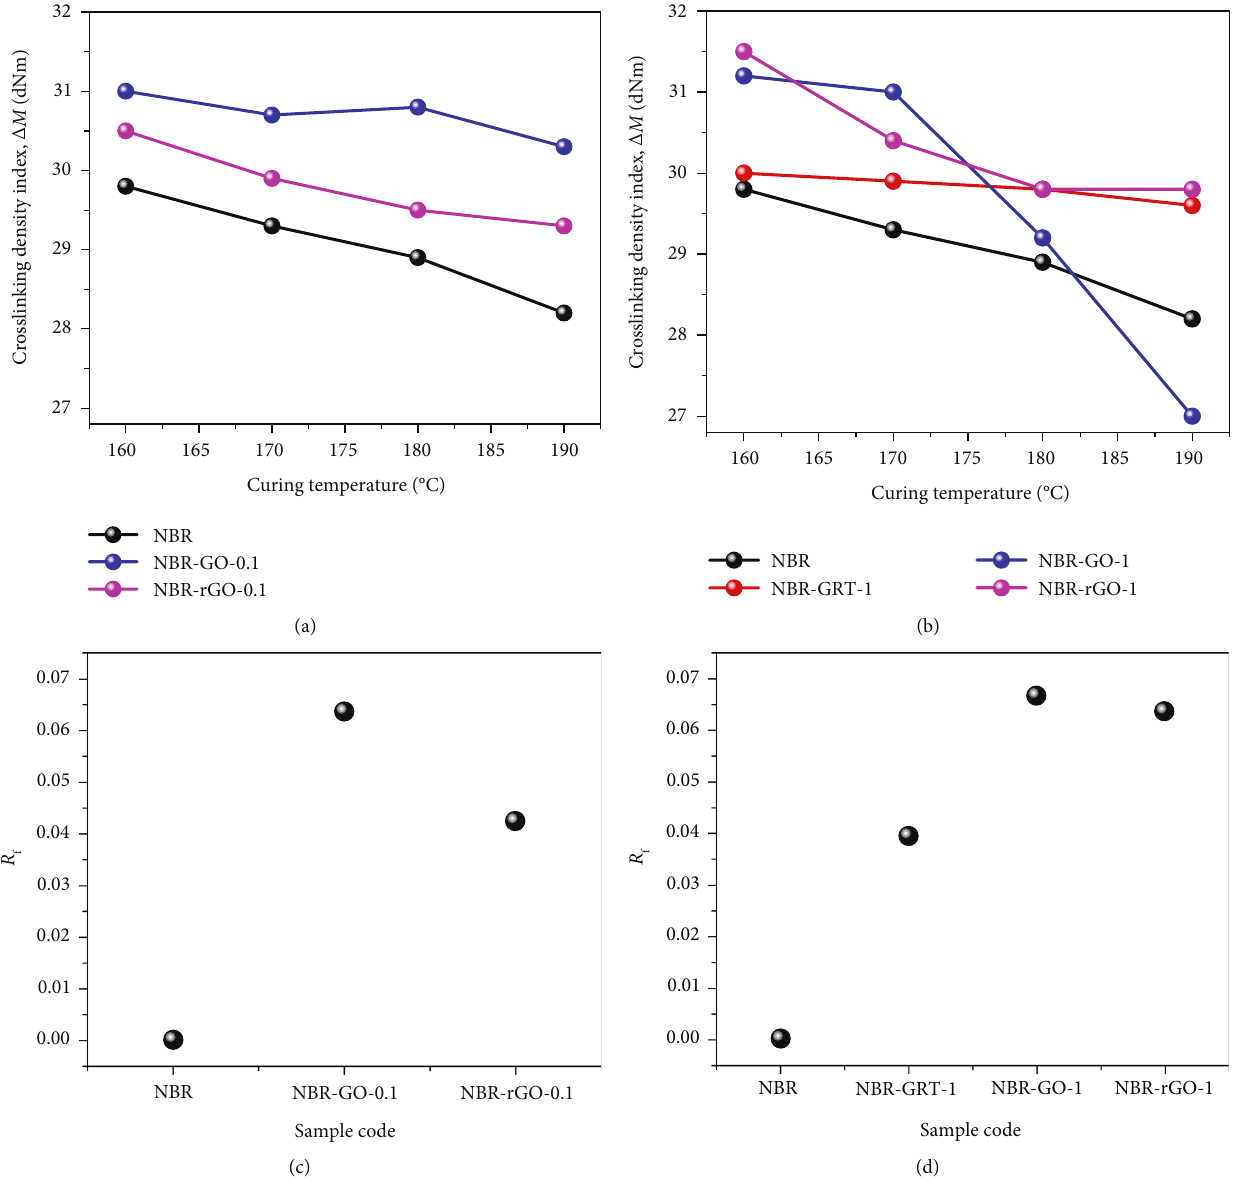
Figure 10: Network density from cure rheology: (a) at 0.1phr fi lled compounds, (b) at 1phr fi lled compounds and reinforcing factor for (c) 0.1phr fi lled compounds, and (d) 1phr fi lled